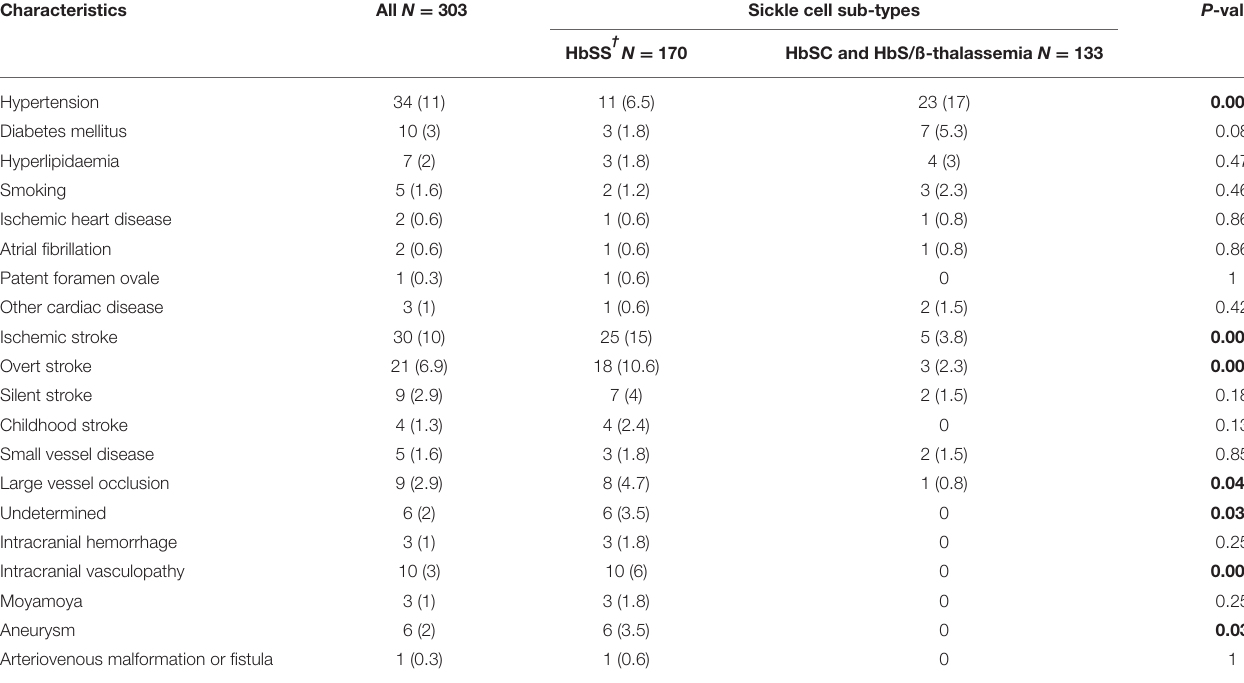
TABLE 2 | Cerebrovascular disease risk factors and classification of sickle sub-types.